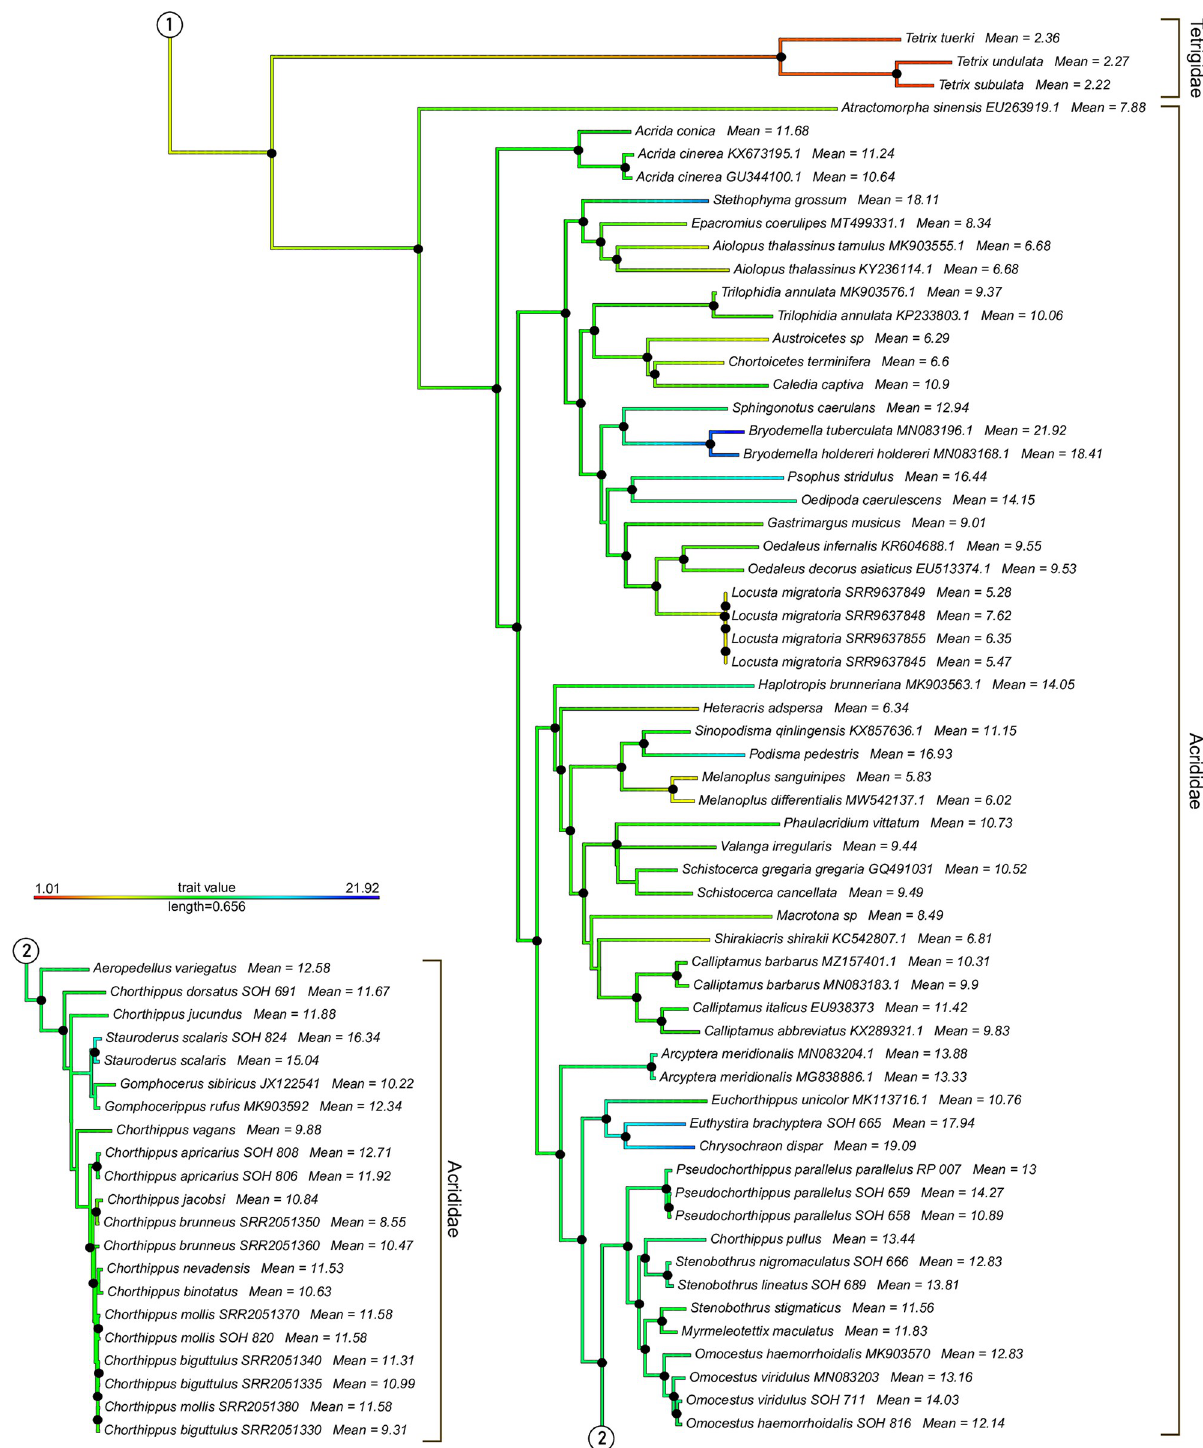
Fig 3. Maximum likelihood phylogenetic tree of the mitochondrial dataset of Orthoptera. Black dots on nodes represent Bootstrap support values of > 95%. Branch colors code genome size (see legend). Mean genome size values are given for all tips. The circled connector “1” links this tree to the tree in Fig 2 The circled connector “2” links parts of the tree shown in this